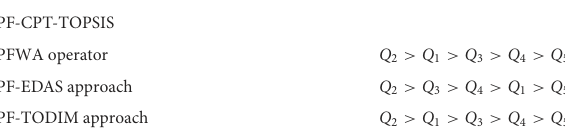
TABLE 16 The contrastive analysis.